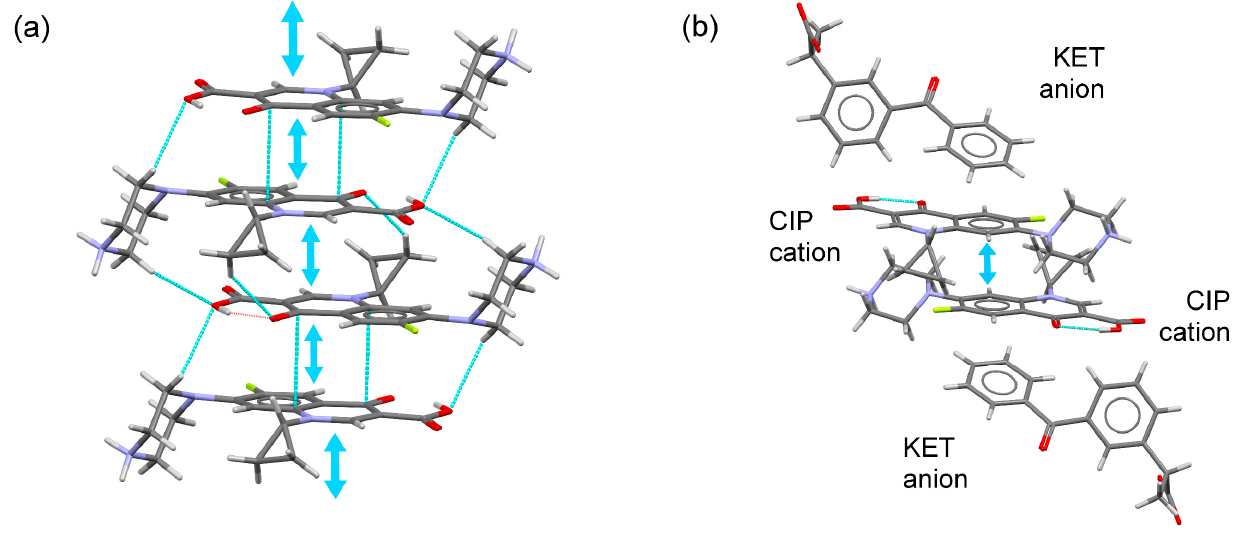
Figure 2. ( a ) Fragment of the infinite CIP column built from π – π stacking interactions. ( b ) A pair of stacked CIP–CIP cations surrounded by NSAID (KET) cations.